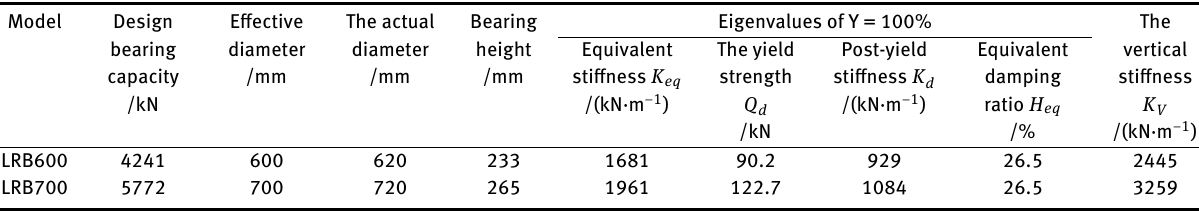
Table 1: Performance parameters of isolation support Model Design